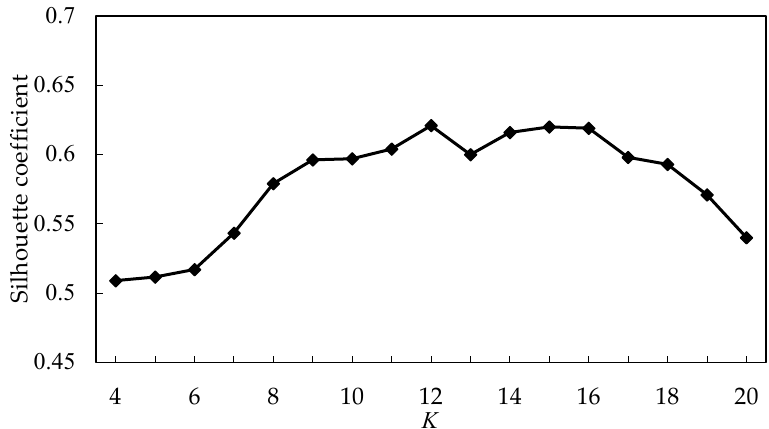
Figure 9. Silhoue tt e coe ffi cient of ROI clustering. Figure 9. Silhouette coefficient of ROI